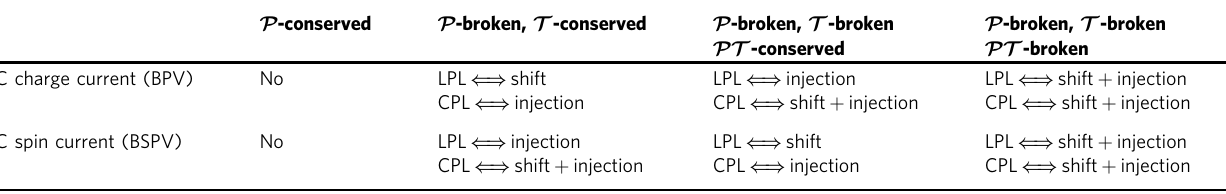
For the shift mechanism, the conductivity contribution is independent of the carrier lifetime τ . For the injection mechanism, the conductivity contribution scales linearly with τ